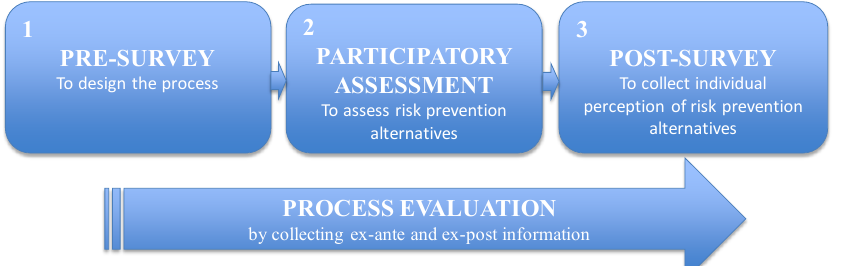
Fig. 1. Scheme of the proposed